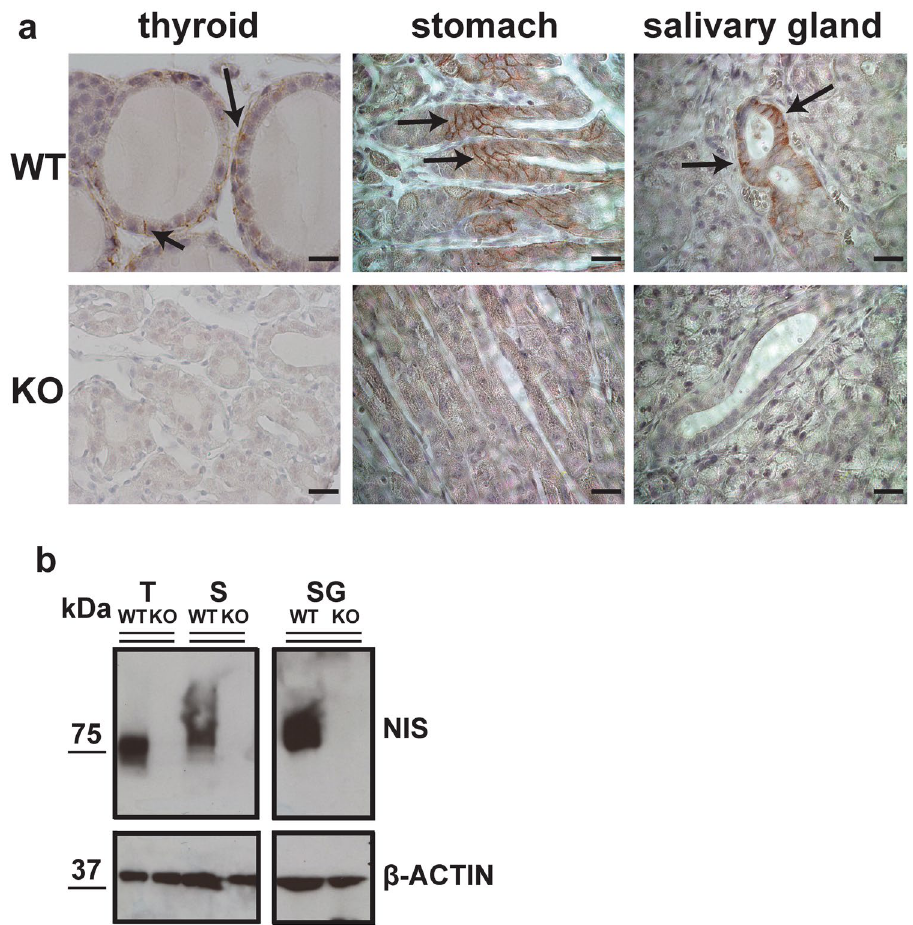
Figure 2. NIS protein expression is abolished in NIS KO mice. ( a ) Sections of thyroid, stomach, and salivary glands obtained from WT or NIS KO mice fed a CD were incubated with anti-NIS Ab and IHC performed as described in Materials and Methods. Arrows indicate the typical basolateral NIS staining observed in organs from WT mice. NIS KO mice did not show any specific staining. Scale bar = 10 µ m. ( b ) WB analysis of NIS expression in organs from WT and NIS KO mice. Images were cropped from the full images presented in Supplementary Figure